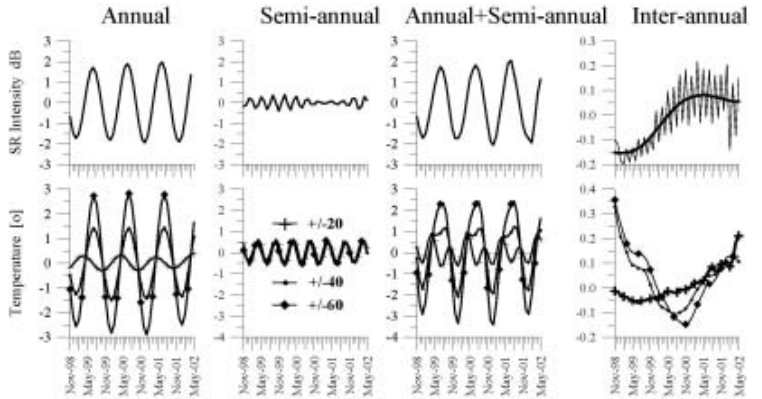
numbers 2 and 3 refer to an annual variation, and columns